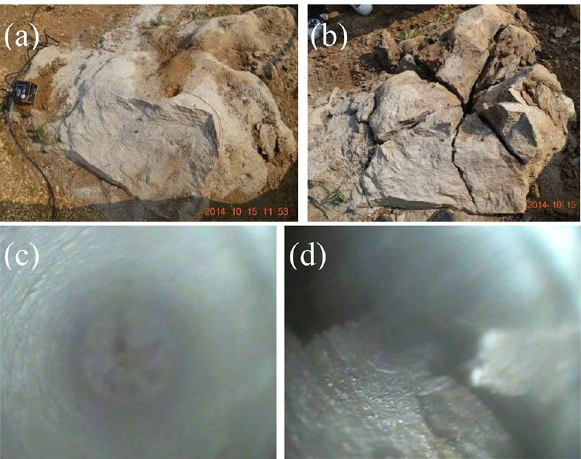
Fig. 10 Rock failure modes before and after underwater blasting: orifice a before and b after blasting; hole bottom c before and d after